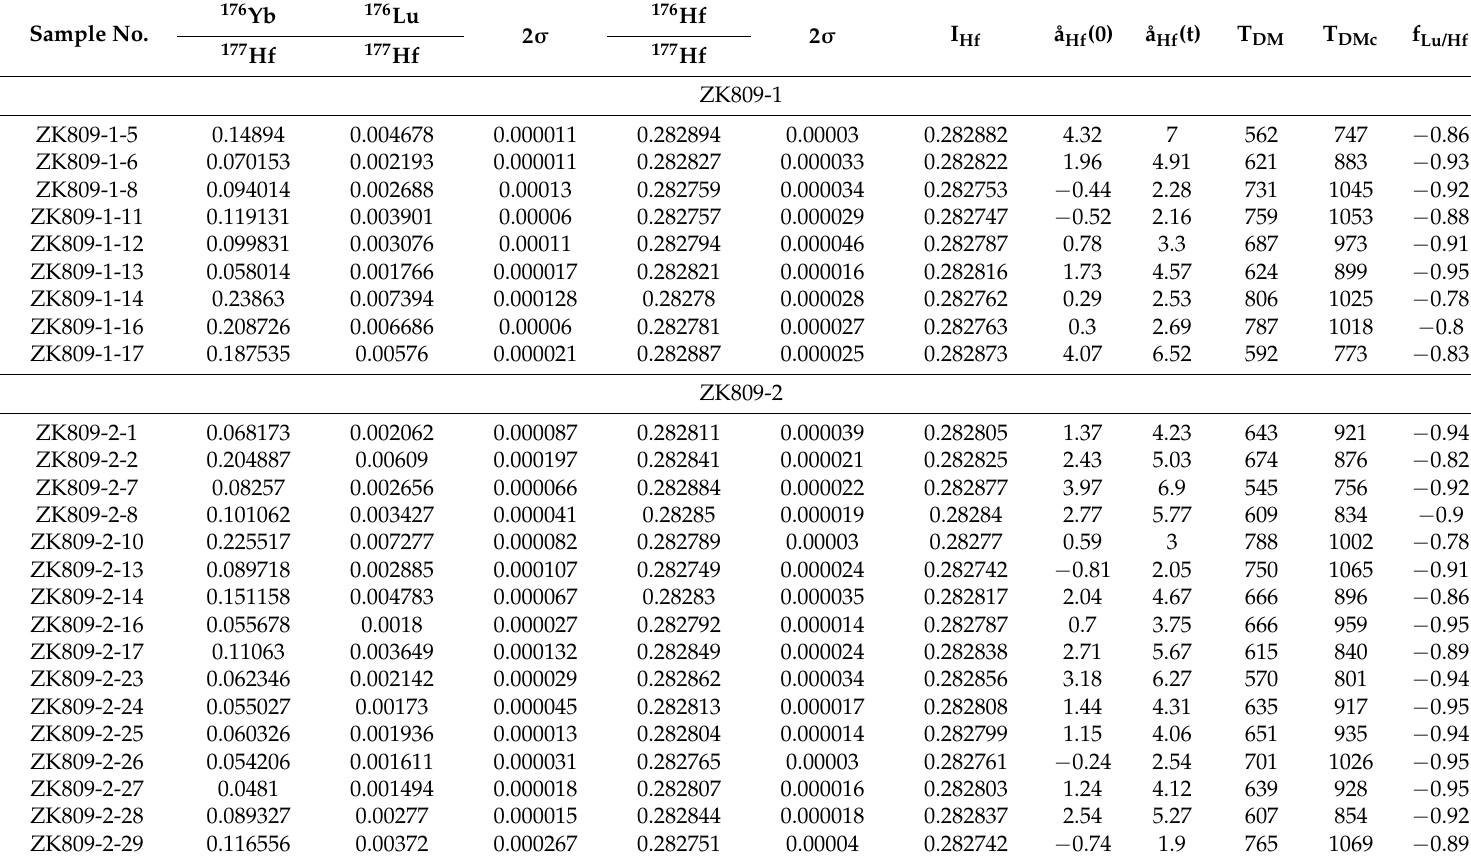
Table 4. Zircon Hf isotopic composition for zircons from quartz porphyry from the Weilasituo Sn-polymetal deposit. Sample